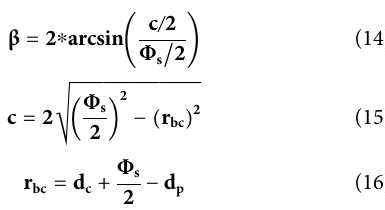
FIGURE 5 Force-displacement backbone curve for the over-stroke behaviour of the DCCSS bearing.